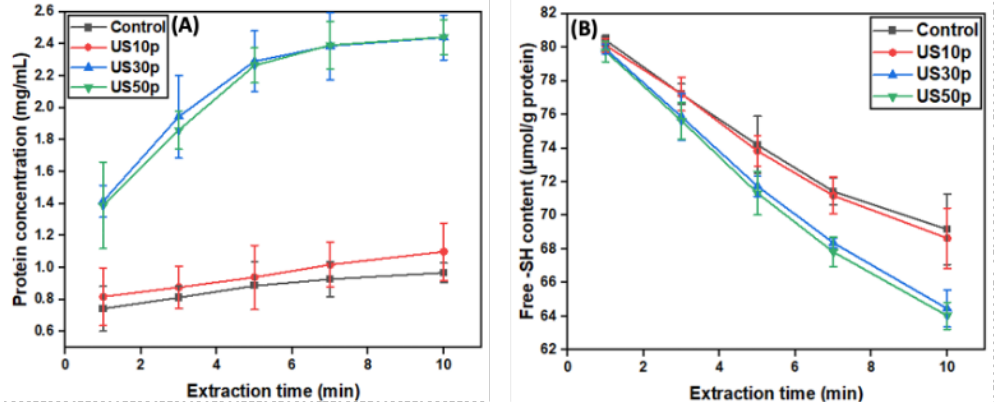
Figure 1. The diagram of the effects of ultrasound as a time function on the hempseed protein extraction process. The protein concentration and free sulfhydryl content changes could reflect the process of protein solubilization and disulfide bond formation. The alkaline extraction condition was set at a fixed pH of 10.0. ( A ) The effect of ultrasound power-time on protein extraction yield. ( B ) The effect of ultrasound power-time on thiol content changes. In this figure, control represents using the conventional magnetic stirring method. US10p, US30p, and US50p represent the sonication power of 11.2 W/cm 2 , 26.8 W/cm 2 , and 50.0 W/cm 2 , respectively. Experiments were conducted in triplicates.